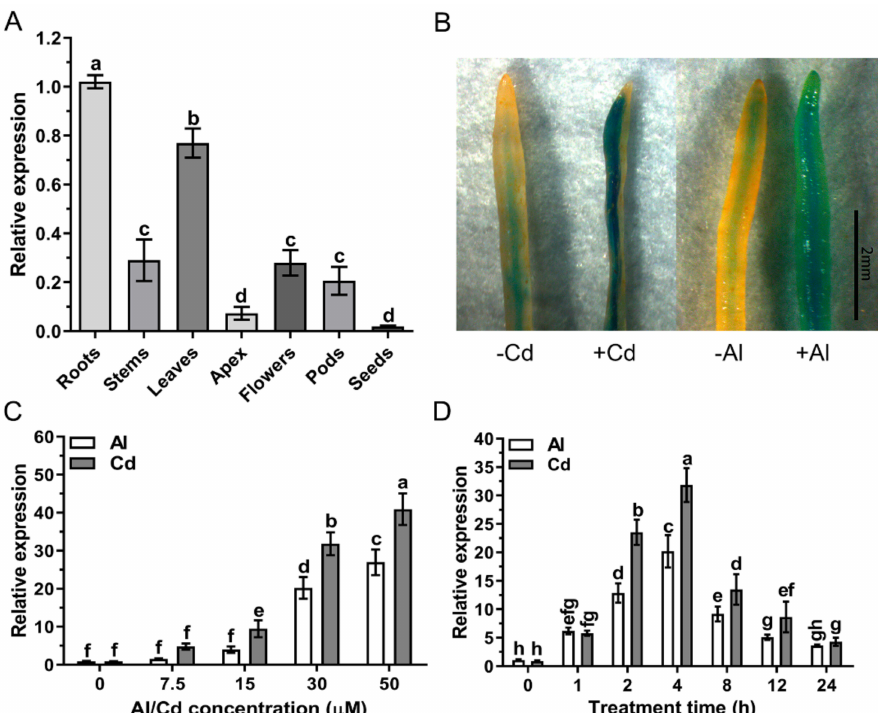
Figure 3. Expression pattern analysis of GsAAE3 . ( A ) Tissue expression pattern of GsAAE3 . The samples of whole roots, stems, leaves, apex, flowers, pods, and seeds were collected when the plants were already in seed-filling stage. ( B ) ( β -glucuronidase) GUS staining in GsAAE3 promoter- GUS transgenic hairy roots. ( C ) Dose-dependent expression of GsAAE3 in wild soybean root tips (0–2 cm). The seedlings were cultured in the nutrient solution added with 0, 7.5, 15, 30, or 50 µ M CdCl 2 or AlCl 3 for 4 h. ( D ) Time-dependent expression of GsAAE3 in wild soybean root tips (0–2 cm). The seedlings were cultured in the nutrient solution added with 30 µ M CdCl 2 or AlCl 3 for 0, 1, 2, 4, 8, 12, or 24 h. The expression of GsAAE3 was determined by qRT-PCR. Three independent biological replicates were performed, and the data are presented as the means ± SD. Di ff erent letters indicate statistically significant di ff erence, using one-way ANOVA and Duncan’s test ( p ≤ 0.05).